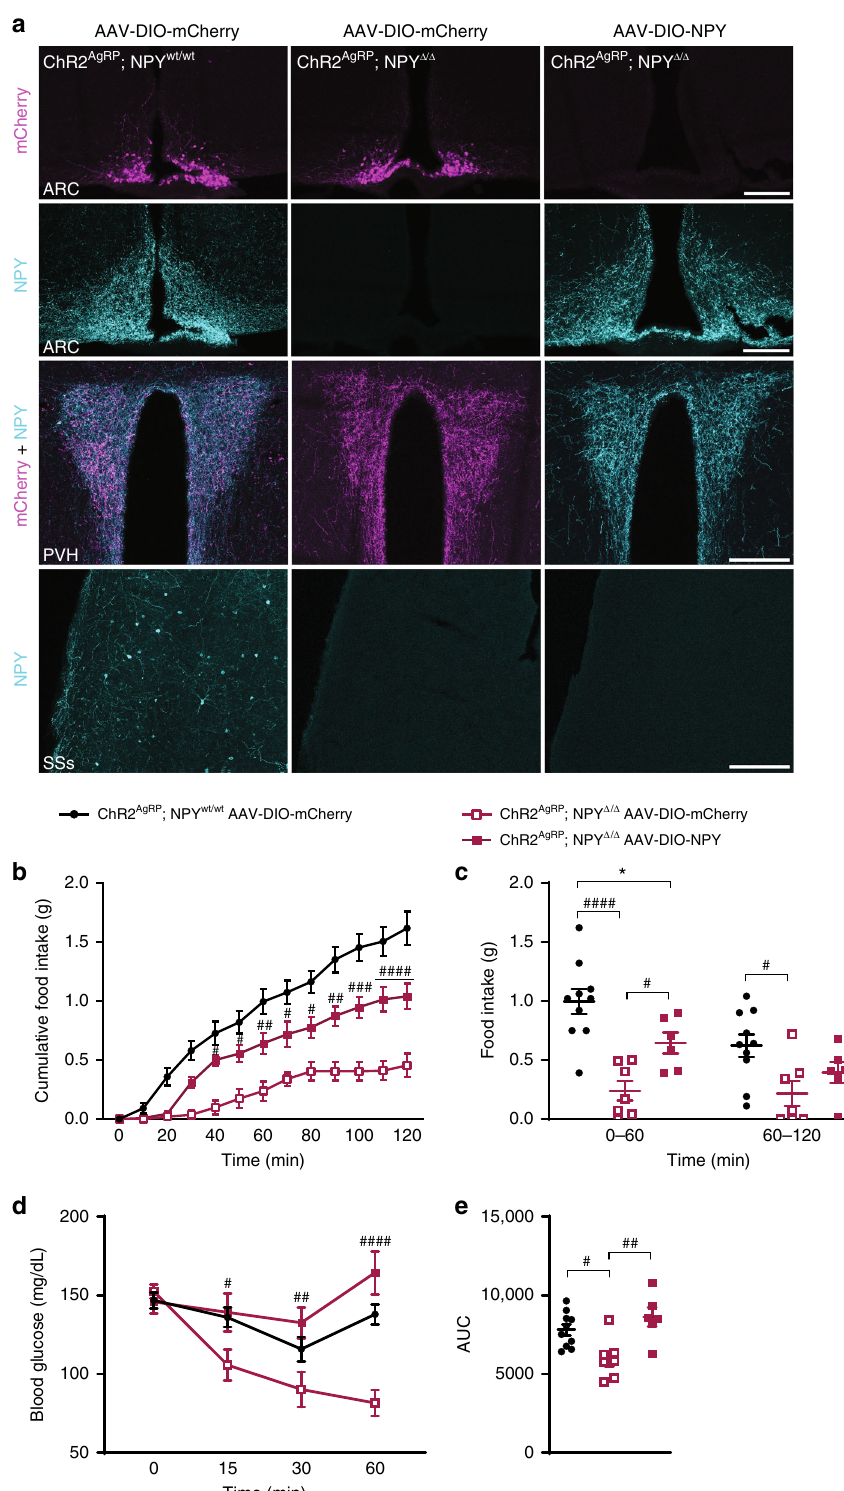
responses 17 , bone mineral density 18 , and sensation of pain 19 . Ablation of these neurons in adult mice induces starvation due to disinhibition of CGRP-expressing neurons in the lateral para- brachial nucleus 20,21 , while their chemogenetic or optogenetic stimulation evokes voracious feeding. They are activated upon fasting, inhibited upon refeeding as well as transiently and rapidly inhibited during the sensory perception of food 2 . Here, sensory